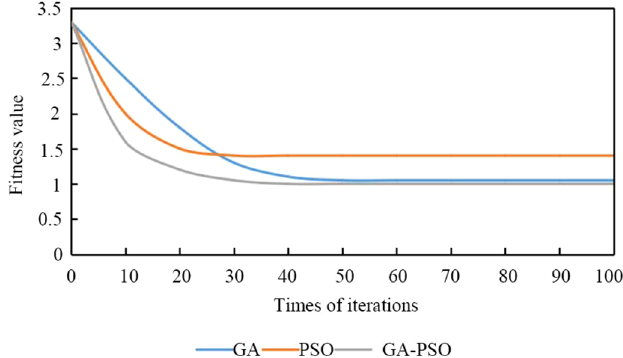
Fig. 5. Convergence curves of three parameter-optimization algorithms.